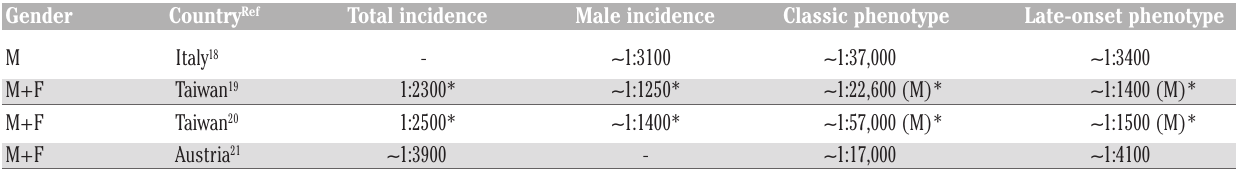
Table 1. Epidemiology of Anderson-Fabry disease. Data from newborn screening based on a -Gal A activity and GLA gene analysis on dried blood spot. Gender Country